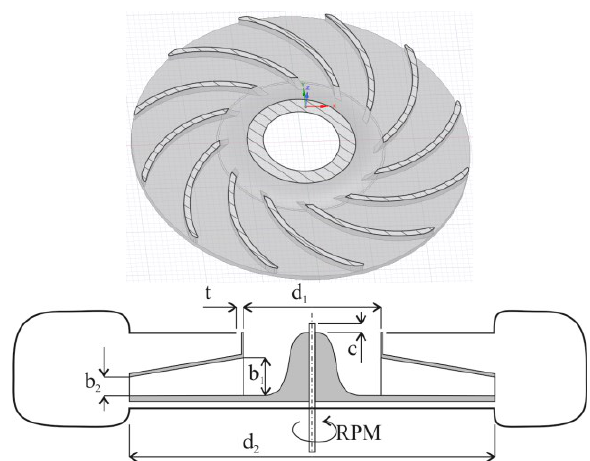
Fig. 1 Design of fan wheel under